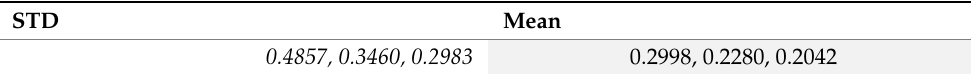
Table 1. Standard deviation and mean for the training dataset.